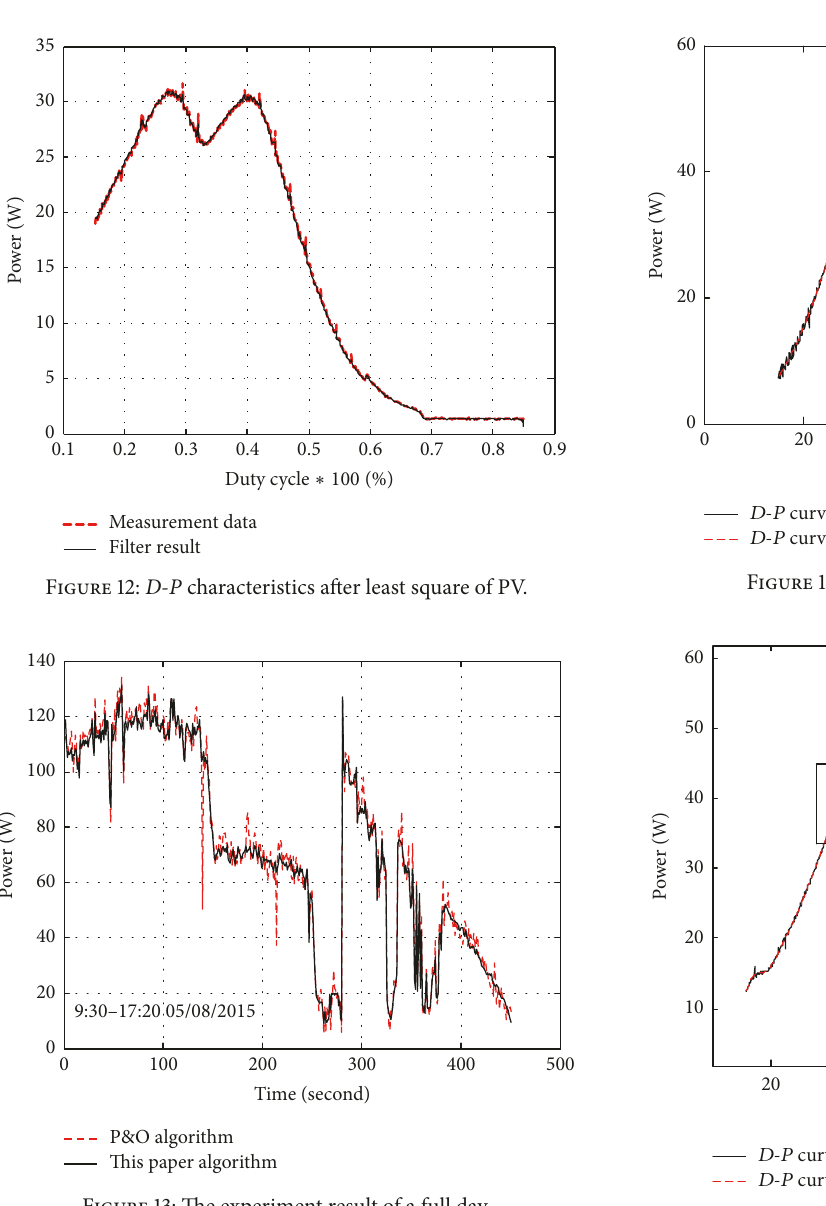
Figure 13: The experiment result of a full day.